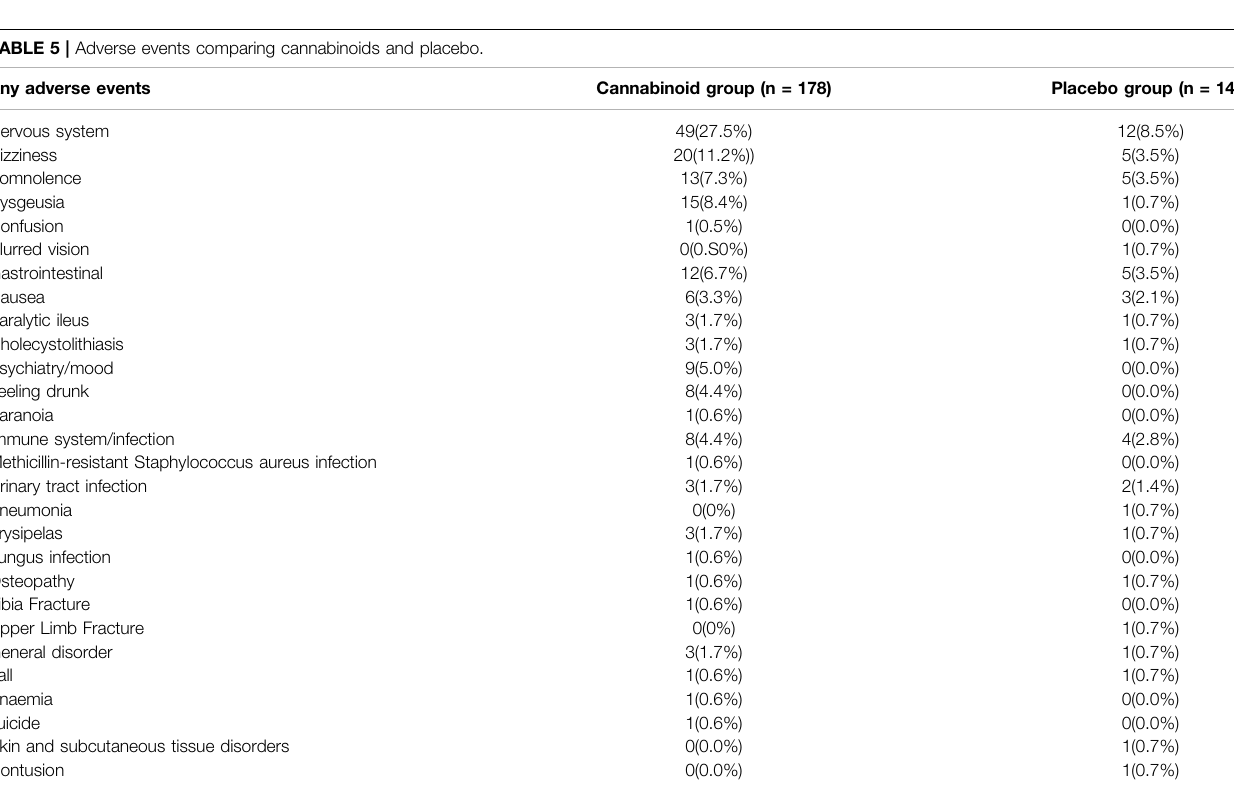
TABLE 5 | Adverse events comparing cannabinoids and